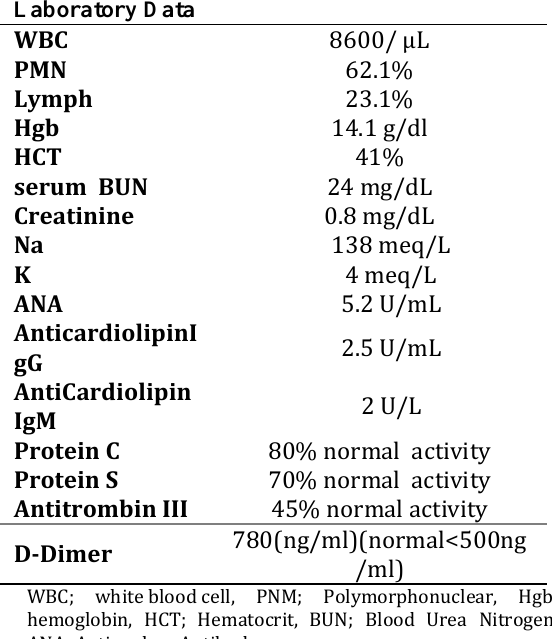
Table1: Laboratory data Laboratory